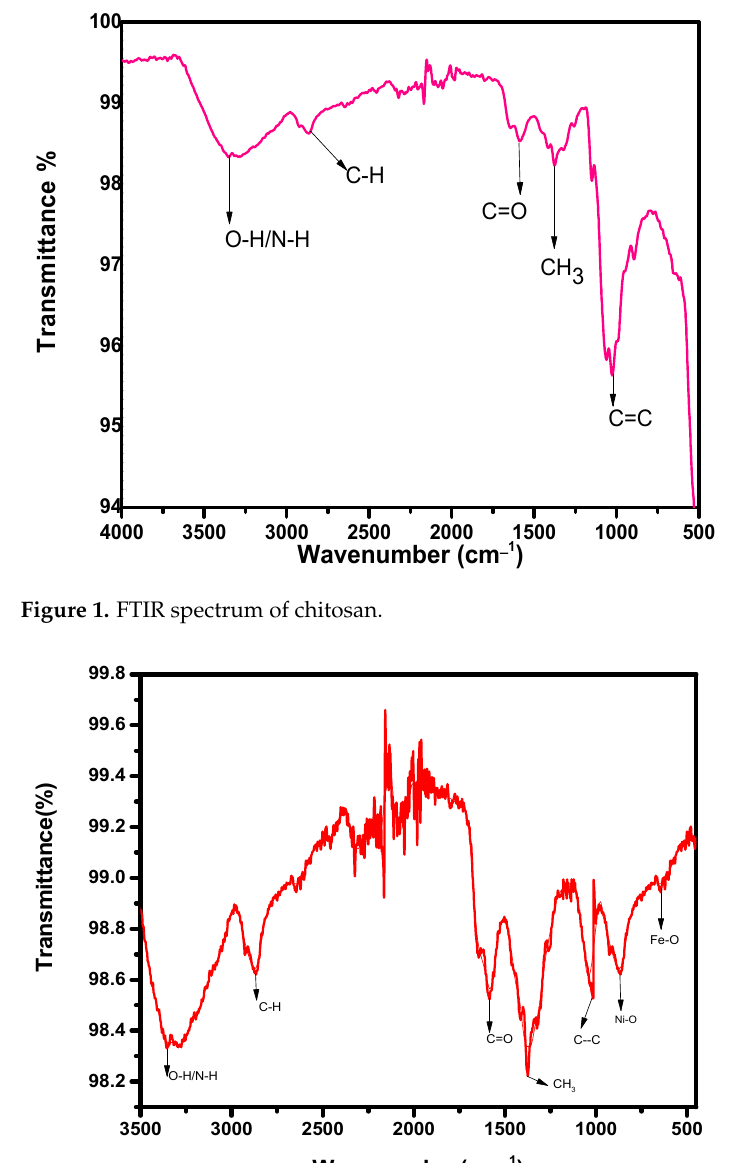
Figure 2. FTIR spectrum of CS-NM bio-composite.